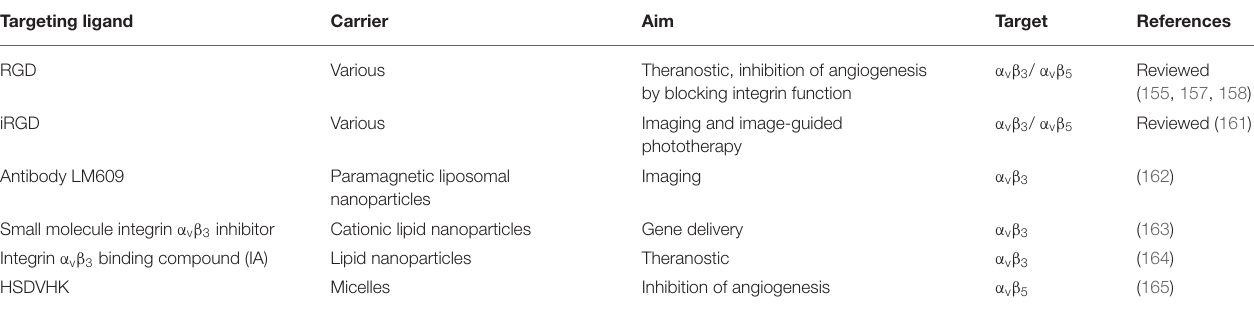
TABLE 5 | Selected examples of NMs targeting endothelial